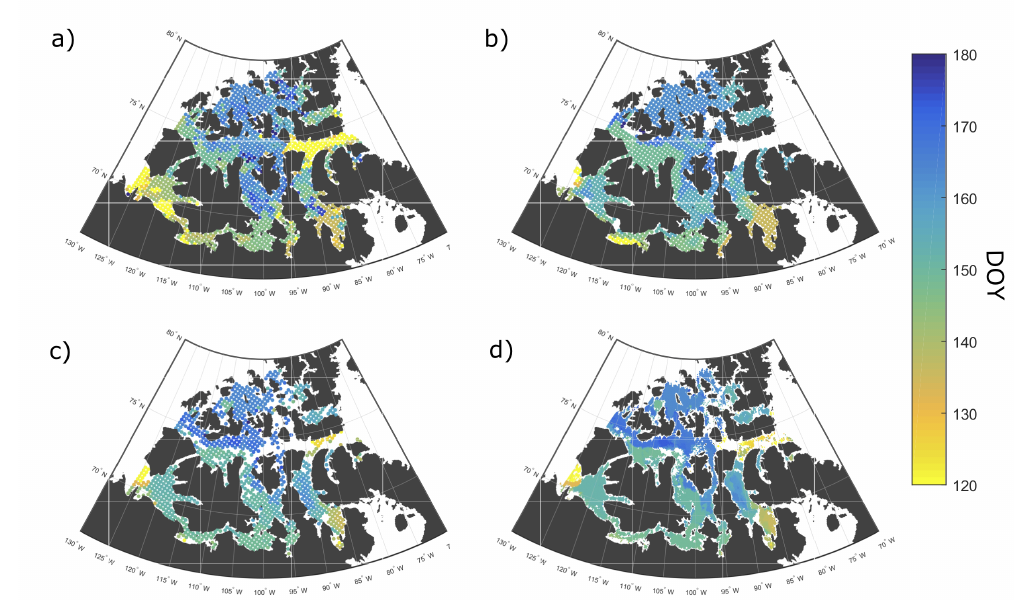
Figure 4. MO dates in the CAA for 2003. ( a ) AHRA 25 km grid, ( b ) PMW 25 km grid, ( c ) DTVM 25 km grid, ( d ) DTVM 6 km Grid.